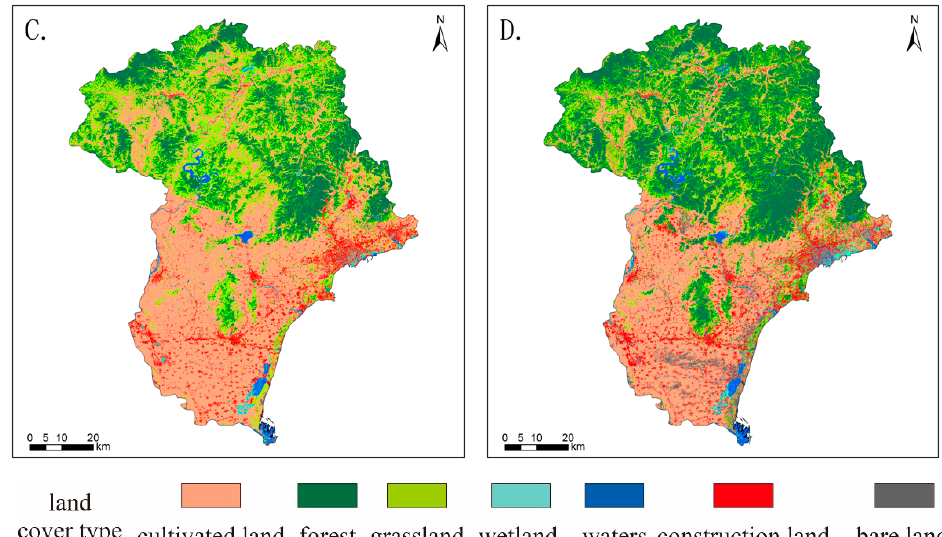
Figure 7. Comparisons between three true color classification methods based on pixels ( A : Landsat 8 Operational Land Imager (OLI) (RGB: Bands 5, 4, 3), B : DCNN, C : support vector machine (SVM), and D : maximum likelihood classification (MLC)).